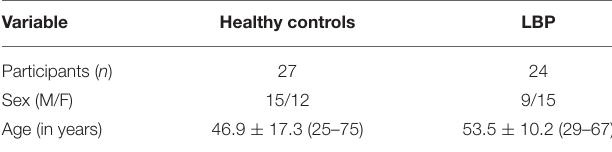
TABLE 1 | Participants’ demographic